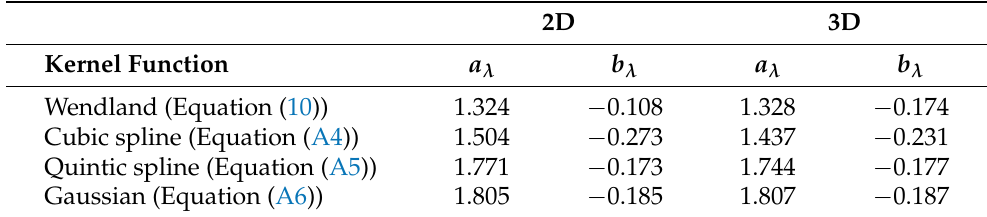
Table A1. Parameters for the Ξ λ approximation function (Equation